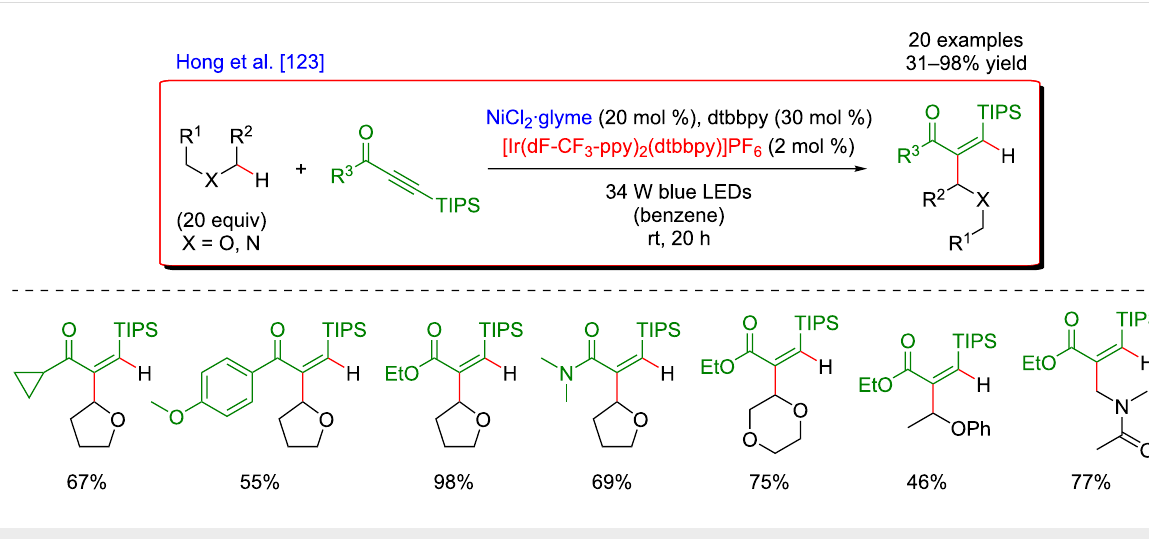
Figure 70: Alternative procedure for the C–H hydroalkylation of ynones, ynoates, and